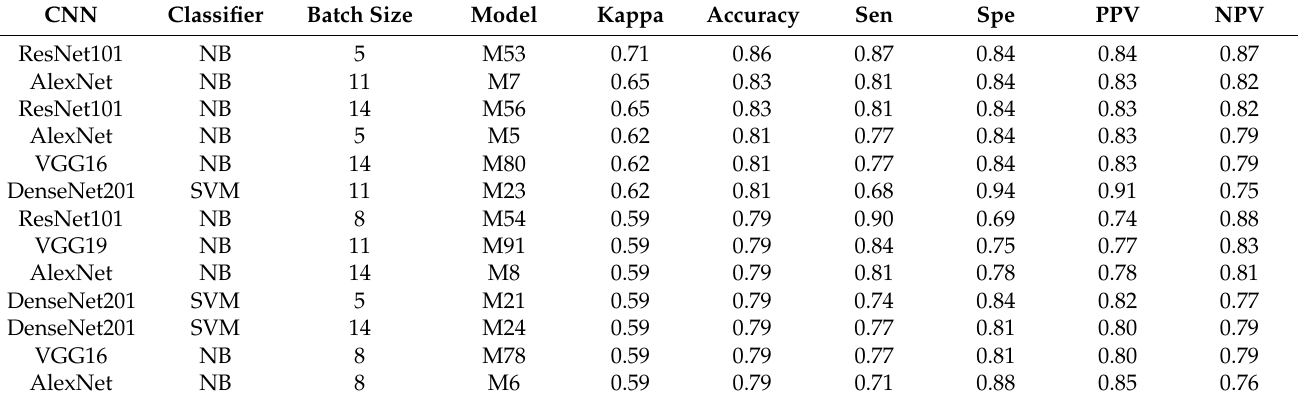
Table 3. Models with kappa values greater than 0.59.